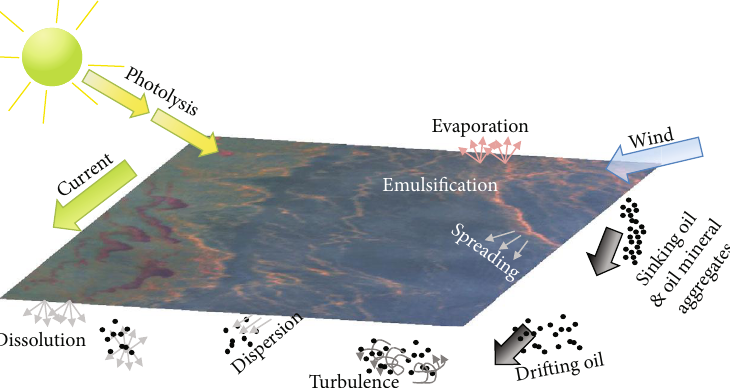
Figure 7: Schematic of important early oil slick processes on timescales of up to a few days. Oil image derived from the Airborne Visual Infrared Imaging Spectrometer of the Deepwater Horizon oil spill. Wind and current directions are approximate based on the spatial pattern of the oil slicks. Adapted from Leifer et al.